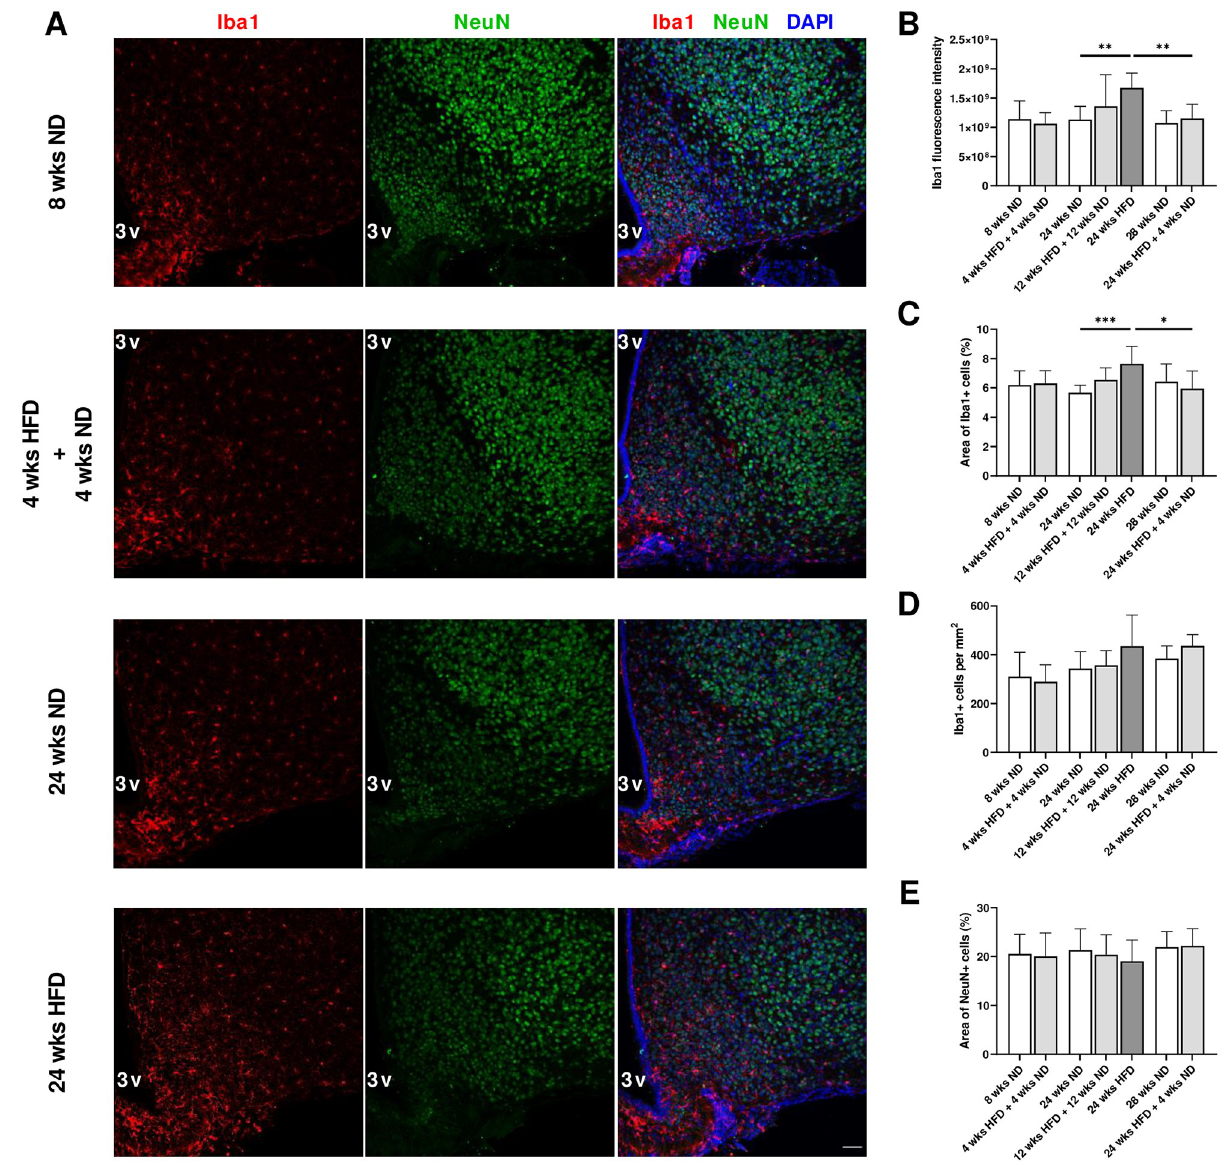
Fig 7. Increased microglial activation after long periods of HFD in the hypothalamus. (A) Representative confocal images of double-labeled immunofluorescence staining for Iba1 (red) and NeuN (green) within the mediobasal hypothalamus of male wild-type C57BL/6J mice fed with ND for eight wks, HFD for four wks followed by ND for four wks and ND or rather HFD for 24 wks. Nuclei were counterstained with DAPI. Scale bar corresponds to 50 μ m; 3v, third ventricle. (B) Fluorescence intensity measurements of Iba1, (C) quantification of percentage of area covered by Iba1 and (E) NeuN-immunoreactive profiles and (D) number of Iba1-immunoreactive cells revealed a microgliosis in response to long-term HFD exposure without effects on neurons. Data are presented as mean values and error bars indicate SD; 8 wks ND n = 6, 4 wks HFD + 4 wks ND n = 6, 24 wks ND n = 12, 12 wks HFD + 12 wks ND n = 6, 24 wks HFD n = 6, 28 wks ND n = 6, 24 wks HFD + 4 wks ND n = 6; (B): Welch-ANOVA, unpaired t test, (C): One-way ANOVA, unpaired t test; ��� p < 0.001; �� p < 0.01; � p <